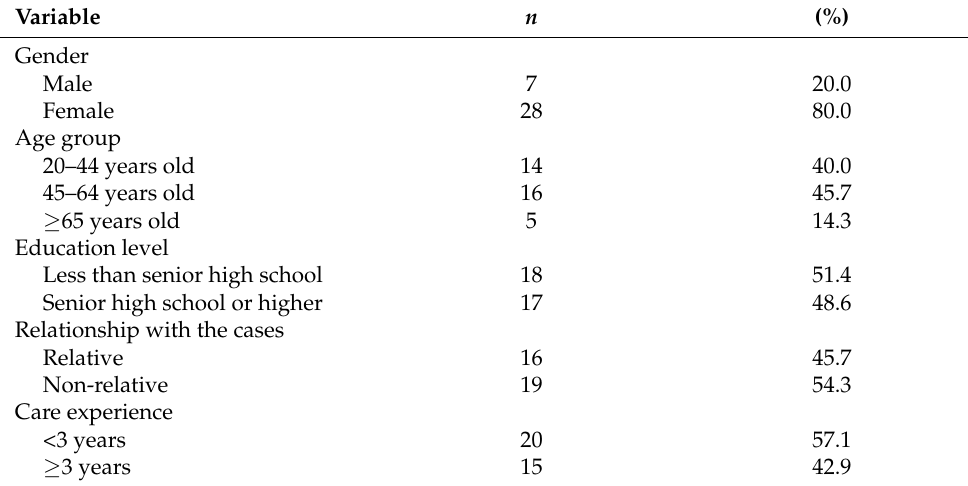
Table 2. Characteristics of participants’ caregivers.